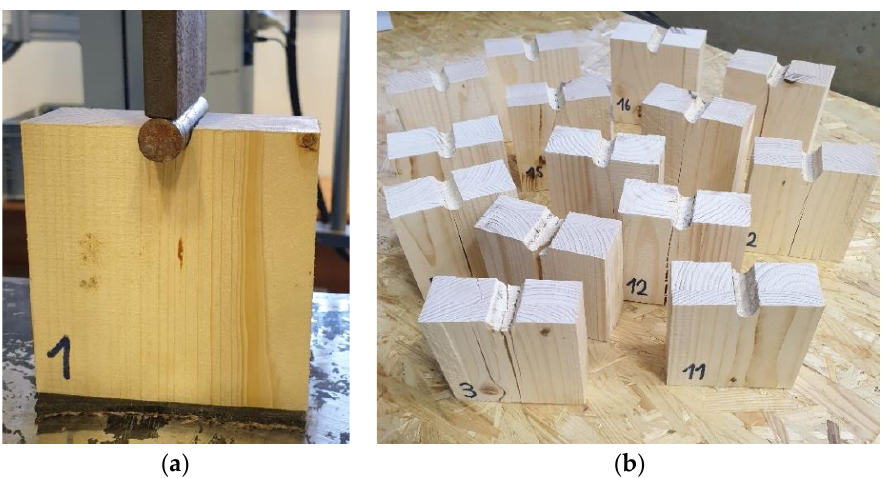
Figure 4. Laboratory test of determination of hole wall strength and compressibility characteristics for dowel fasteners: (a) test sample during the test, (b) test samples after the test.